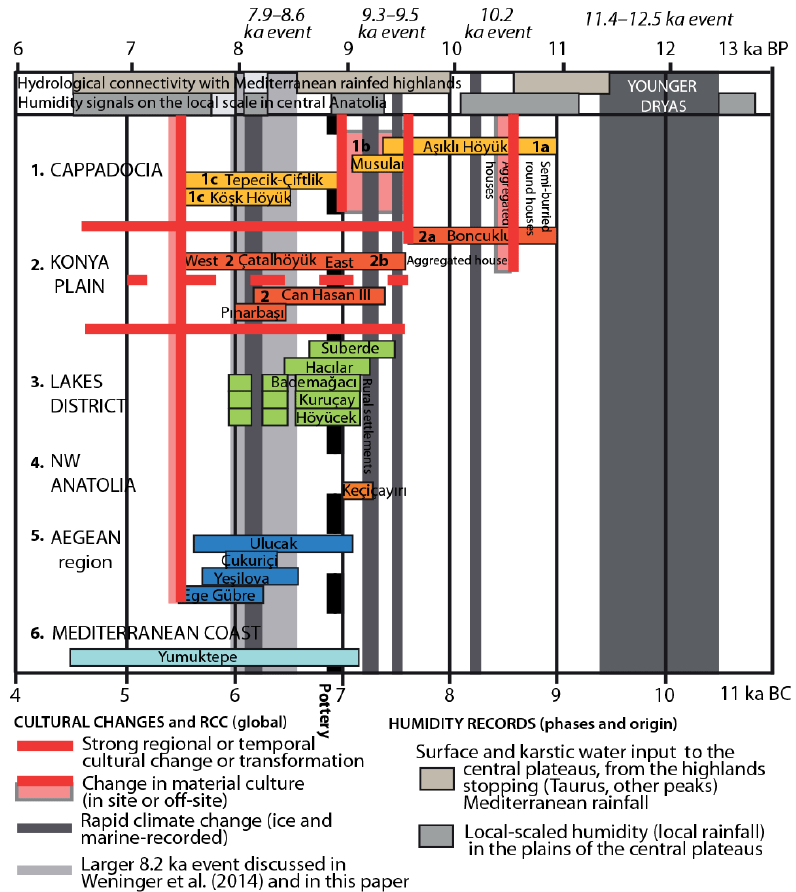
Figure 14. Neolithic dynamic and early Holocene RCC in Anatolia. Note: sites are selected on the basis of being the oldest ones excavated in their region (i.e. sites founded after 8.0kacalBP are not shown) (sources: Fontugne et al., 1999; Kuzucuo˘glu et al., 1997, 1998, 1999; Düring, 2002, 2011; Boyer et al., 2006; Gürel and Lermi, 2010; Özba¸saran, 2011; Baird, 2012; several articles in Özdo˘gan et al., 2012a, b; Kuzucuo˘glu, 2013, 2014; Stiner et al.,